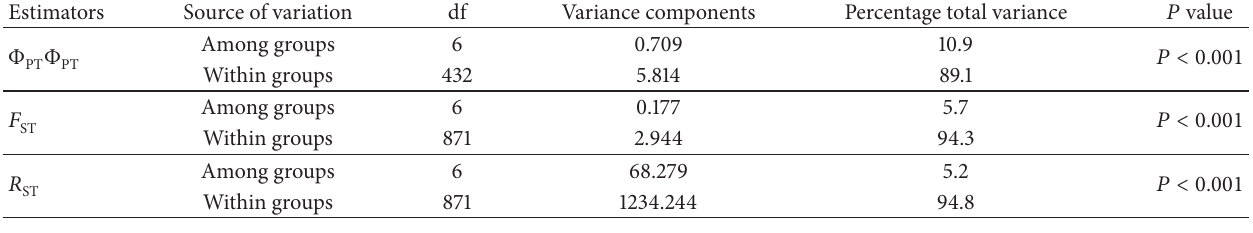
Table 4: AMOVA analysis for the partitioning of SSR variation of olive varieties among and within BAPS groups identified in this study.